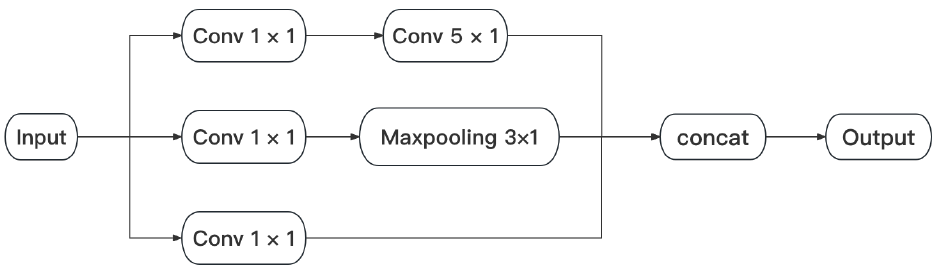
Figure 4. The structure of the external segment attention